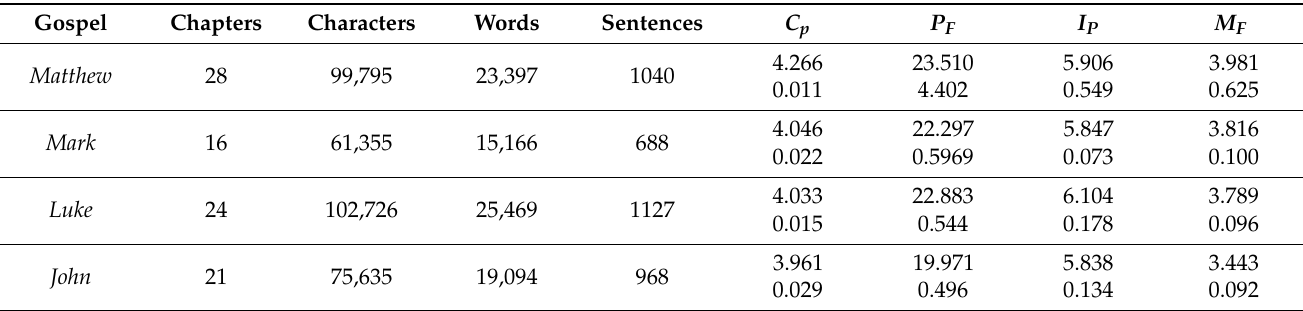
Table 12. Gospels statistics, King James version. Number of chapters (i.e., the number of samples considered in calculating the regression lines of the theory), total number of characters contained in the words, total number of words and sentences, deep language parameters C P , P F , I P , M F , with standard deviation reported in the second